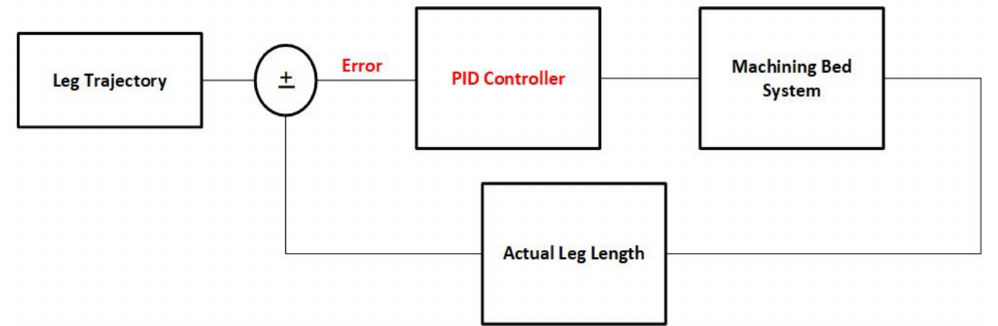
Figure 12. Block diagram of the feedback control model for the machining